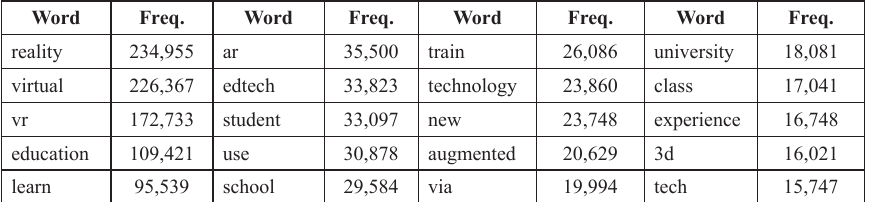
Table 3. Frequency of the top-20 most commonly used words within the tweets